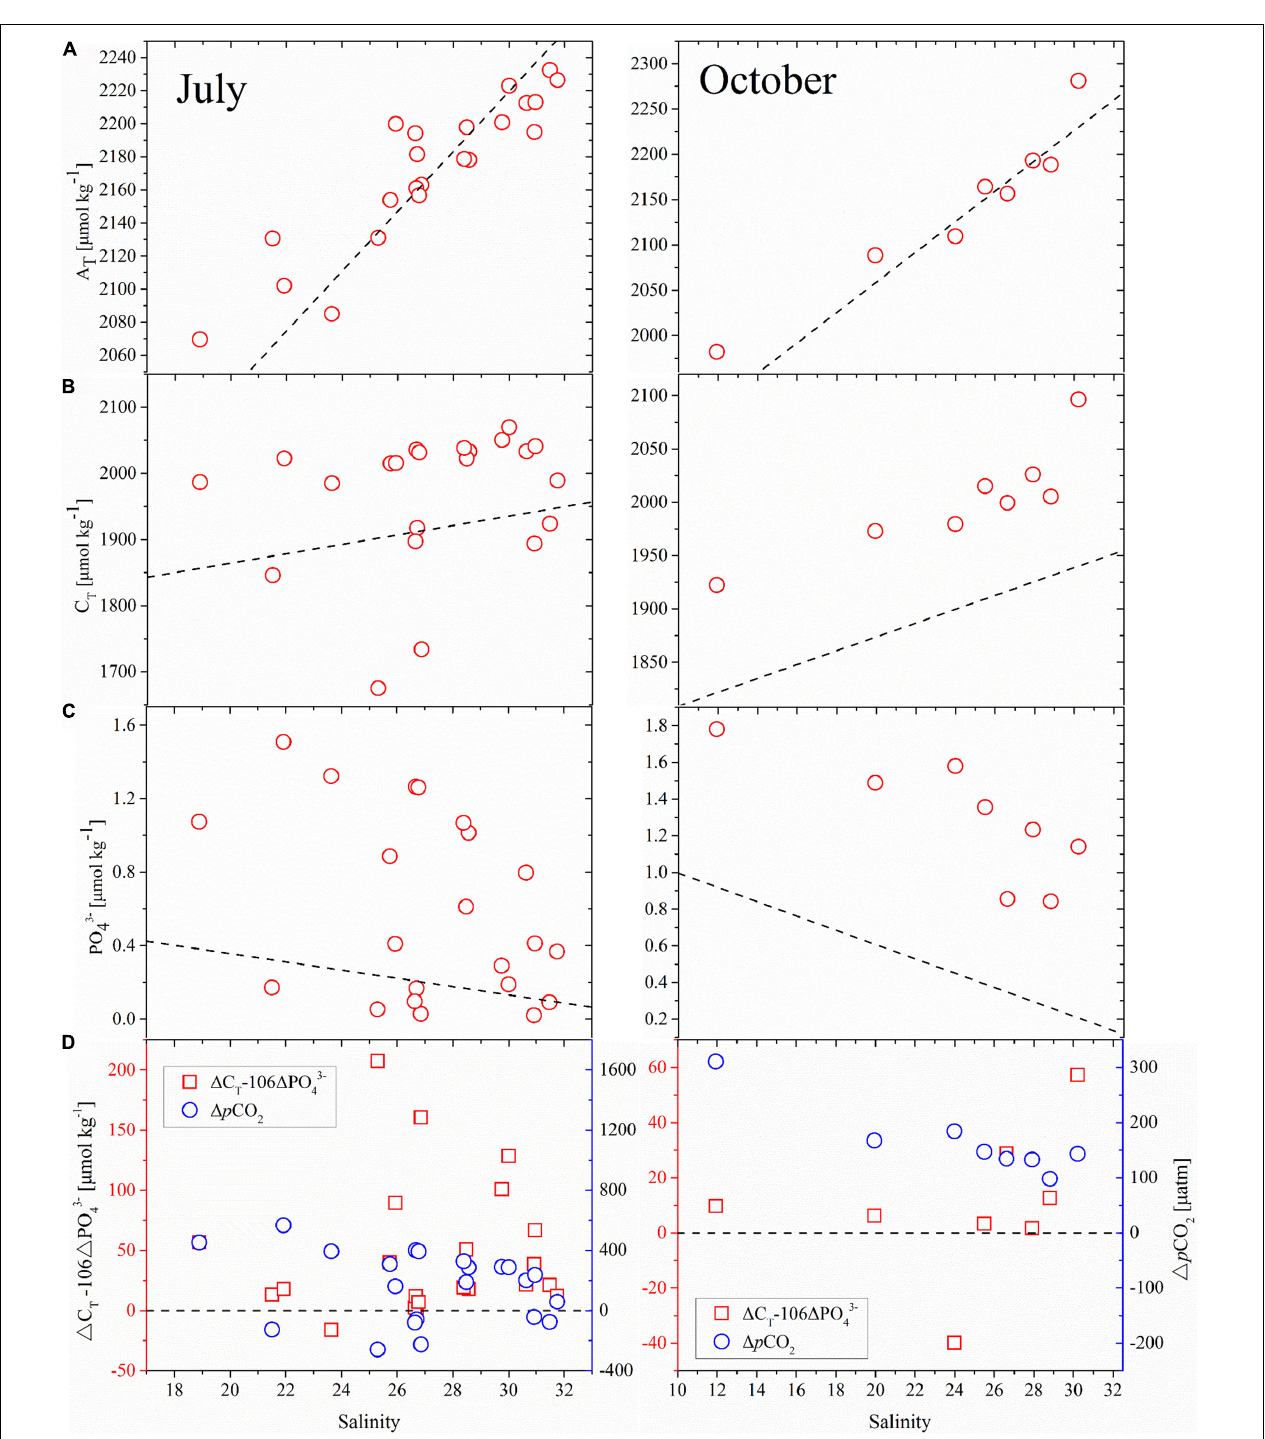
FIGURE 12 | (A) A T , (B) C T , (C) PO 43 − , and (D) (cid:49) C T –106 (cid:49) PO 43 − (red squares) and (cid:49) p CO 2 (blue circles) versus salinity in the surface water of CDW in July and October, 2018. The dashed lines in panels a-c represent the hypothetical mixing line between surface freshwater end-member and seawater end-member, in which A T , C T , and PO 43 − are 1676, 1722, and 0.805 µ mol/kg in July and 1724, 1744, and 1.385 µ mol/kg in October in the freshwater end-member, respectively, and 2310 (Chen and Wang, 1999), 1971 (Chou et al., 2017), and 0.02 µ mol/kg (Chen and Wang, 1999) in the seawater end-member, respectively. The A T and C T values of the freshwater end-member were obtained from Xiong et al. (2019) and the PO 43 − values from station P (121.10 ◦ E, 31.75 ◦ N; Figure 1a ), and the station samples were collected aboard the R/V Chuangxin 2 on July 17 and October 16, 2018. The dashed line in panel d represents the p CO 2 equilibrium between the seawater and the